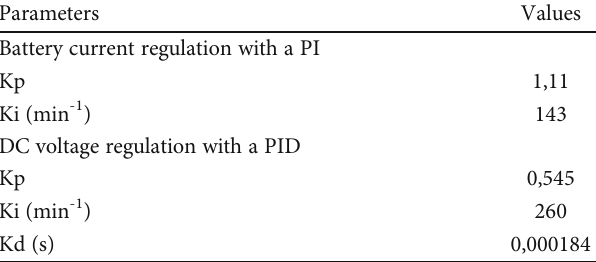
Table 4: Parameters of the classic PI and PID correctors.